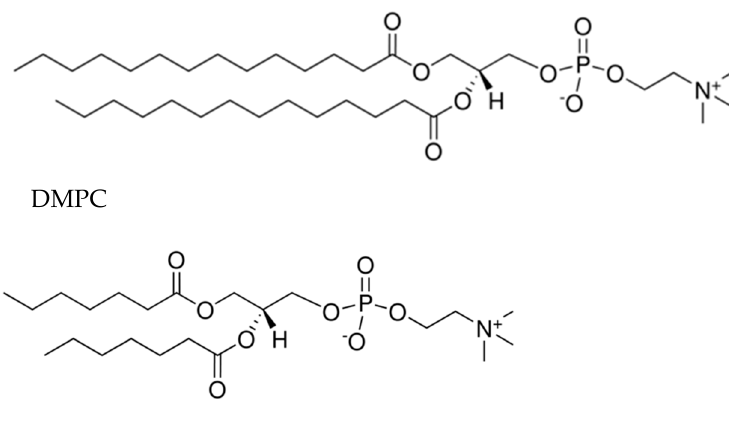
Figure 2. Structures of lipids DMPC (1,2-dimyristoyl-sn-glycero-3-phosphocholine) and DHPC (1,2-